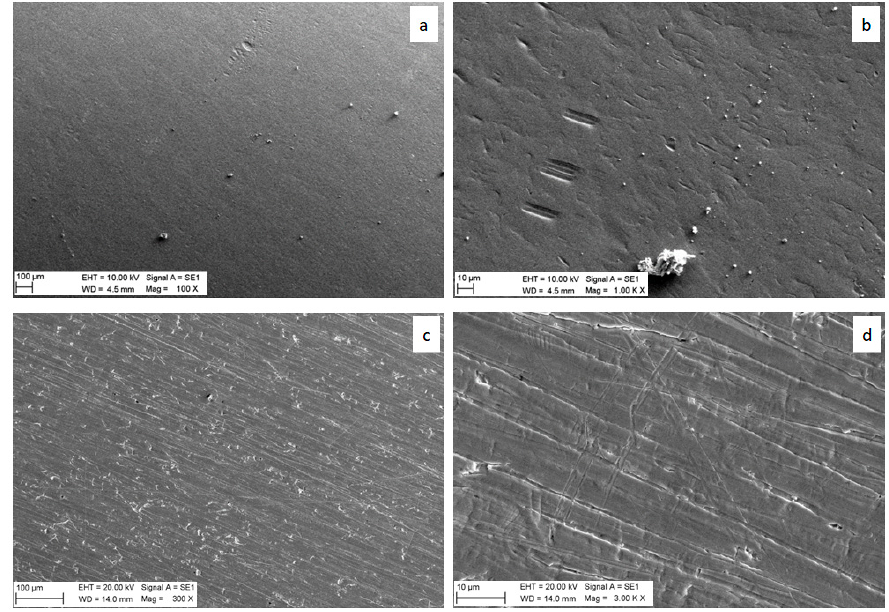
Figure 1. SEM micrographs of the two samples at different magnitude: ( a ) and ( b ) refer to the Pd 77 Ag 23 sample, while ( c ) and ( d ) regard the Pd 30 Ag 70 sample.